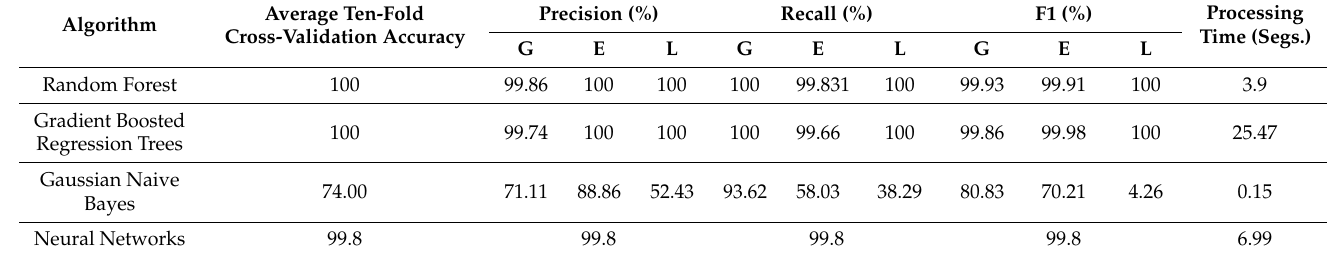
Table 5. Performance of the classifiers using the dataset obtained in step 2.